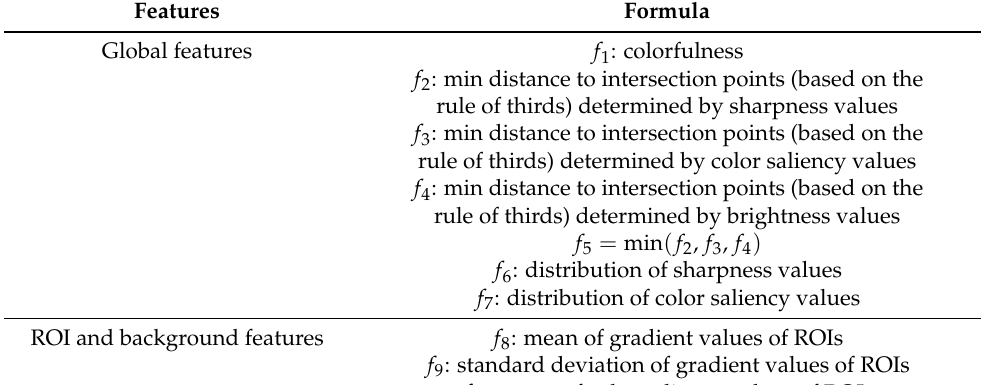
Table 7. Overview of the proposed handcrafted features F c